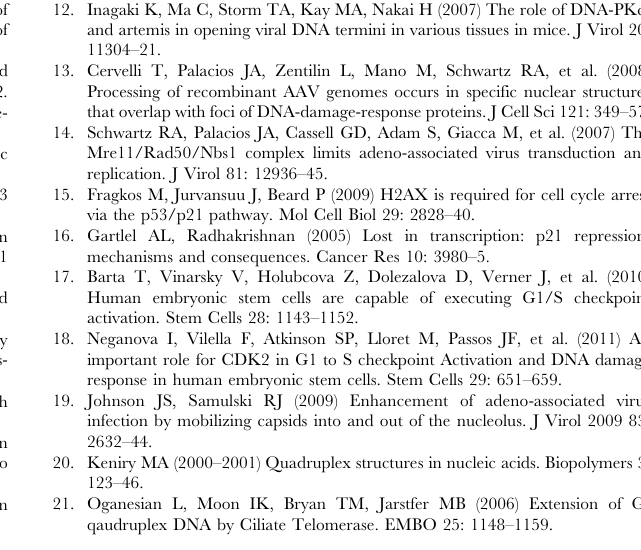
Figure S2 Recombinant AAV Transduction of hESC WiCell H1s. A ) WiCell H1s were transduced with 100,000 particles of scAAV3B-CMV- egfp . The cells were harvested for GFP analysis by flow cytometry 24 h after virus addition. B) Cell viability was measured by dye exclusion at the indicated timepoints following transduction of H1 cells by 100,000 scAAV3B-CMV-egfp particles. C) Total RNA was harvested from transcript GAPDH. D) Rates of mitotic entry for H1 and H9 hESCs. Dual color flow cytometry using a mitosis-specific antibody to phospho-MPM2 epitope (Cy5) and DAPI to analyze DNA content was employed to measure mitotic entry rates. Samples were subjected to nococdazole treatment for 2, 4, or 6 hours. Mitotic entry rates were calculated as linear regression slopes generated from scatter plots of the percentage of MPM2 + Figure S3 Recombinant AAV Transduction of H9 cells Differentiated Towards a Neural Lineage. A) hESCs were grown to embryoid bodies and differentiated towards a neuronal lineage for 15 days. Then, 100,000 scAAV3b-CMV- egfp particles were used for transduction and viability was determined 24 h later by dye exclusion. B) Immuno-fluorescence of cells following scAAV3B-CMV- egfp transduction using an anti-vimentin antibody and the native eGFP fluorescence. Figure S4 Characterization and Transduction of p53 deficient hESCs. (A) Equal amounts of protein from wild type H9 hESCs and those knocked down for p53 transcript [described in (B)] were analyzed for total p53 abundance by Western blotting. Alpha-tubulin served as additional loading controls. (B) Wild type or p53 knockdown hESCs were analyzed for the Oct4 transcript by reverse transcriptase followed by quantitative PCR using cDNA template. The values were normalized to levels of the housekeep- ing transcript GAPDH. Results are presented as transcript induction which is the value determined for AAV infected cells divided by the value determined for the no treatment group (p-